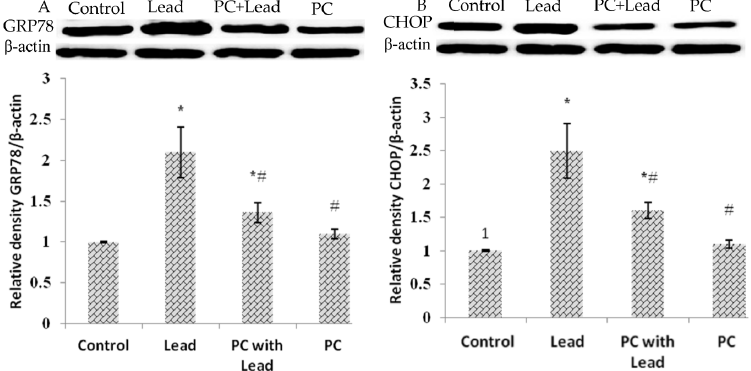
Figure 7. The effect of proanthocyanidins (PCs) on the protein expression levels of GRP78 and CHOP protein in liver tissues of mice exposed to lead. ( A ) GRP78; and ( B ) CHOP. All results are expressed as the mean ± SE ( n = 7). * p < 0.05, significant change with respect to the control; # p < 0.05, significant change with respect to lead-treated